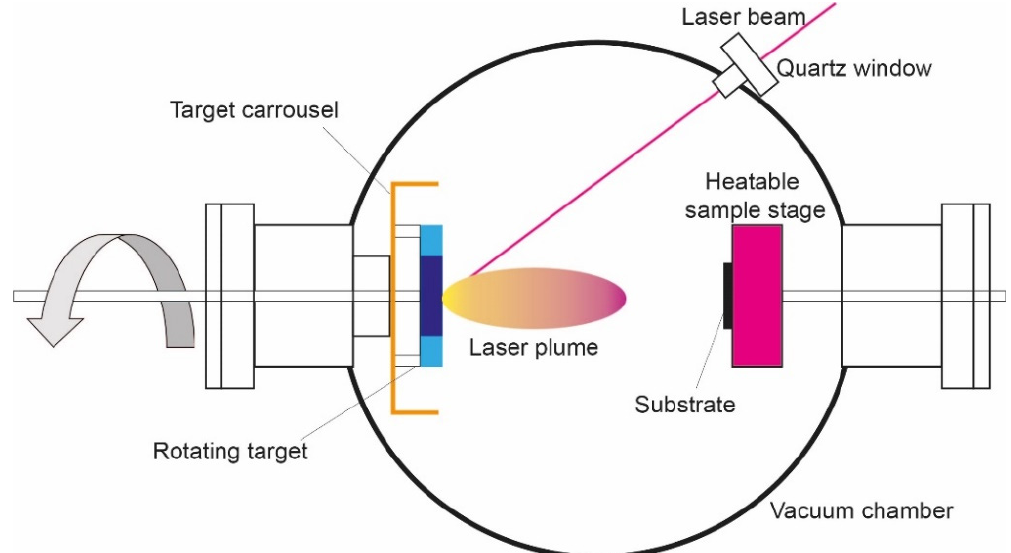
Figure 1. Schematics of a Pulsed Laser Deposition (PLAD) apparatus present at the Department of Physics of the Sapienza Rome University. When a solid target is irradiated by a focalized pulsed laser beam, a gaseous cloud, known as a plume due to its shape, is produced. The plume, a plasma composed of electrons, atoms, ions, molecules, clusters and, in some cases, droplets and target fragments, expands in vacuum, and will be deposited on the substrate, giving rise to a film where fragments of the target (spalls) may be inserted.